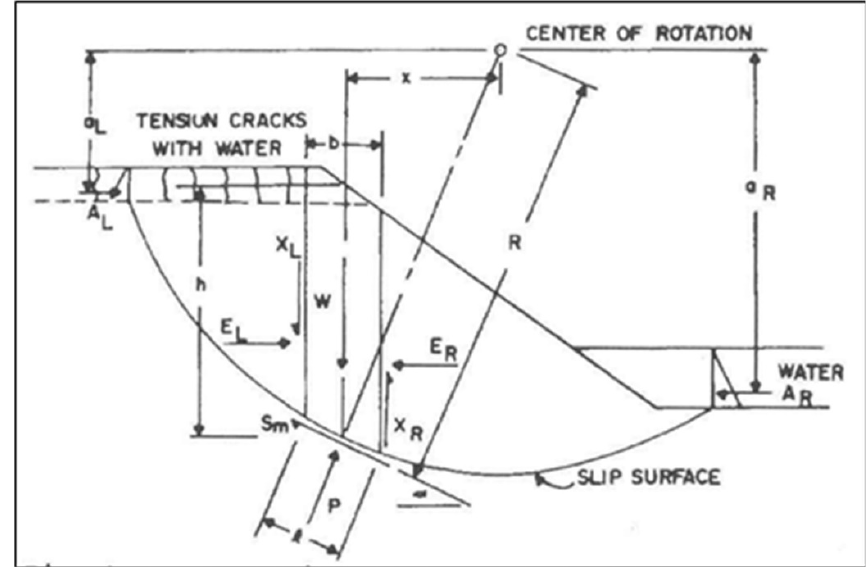
Figure 6. Vertical Slice for Internal Stability Analysis [36].